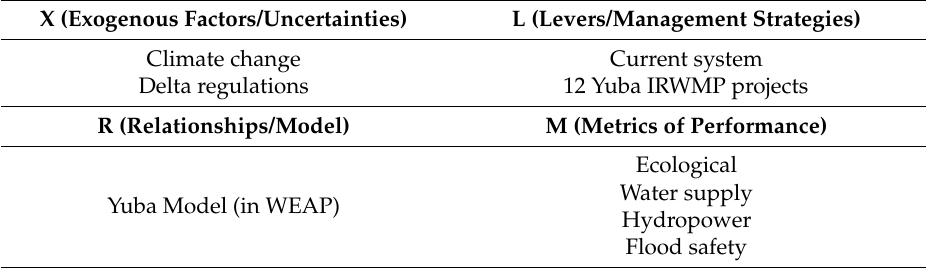
Table 2. Final XLRM problem formulation matrix developed by a focal group of stakeholders representing various constituencies convened by the Yuba County Water Agency in Marysville, California. The initial problem formulation contained two additional dimensions of uncertainty associated with hydropower relicensing and land use change, but these were eliminated from consideration due to the discovery of their relatively small impact, relative to climate change and the eventual Delta regulatory regime, on the vulnerability of the